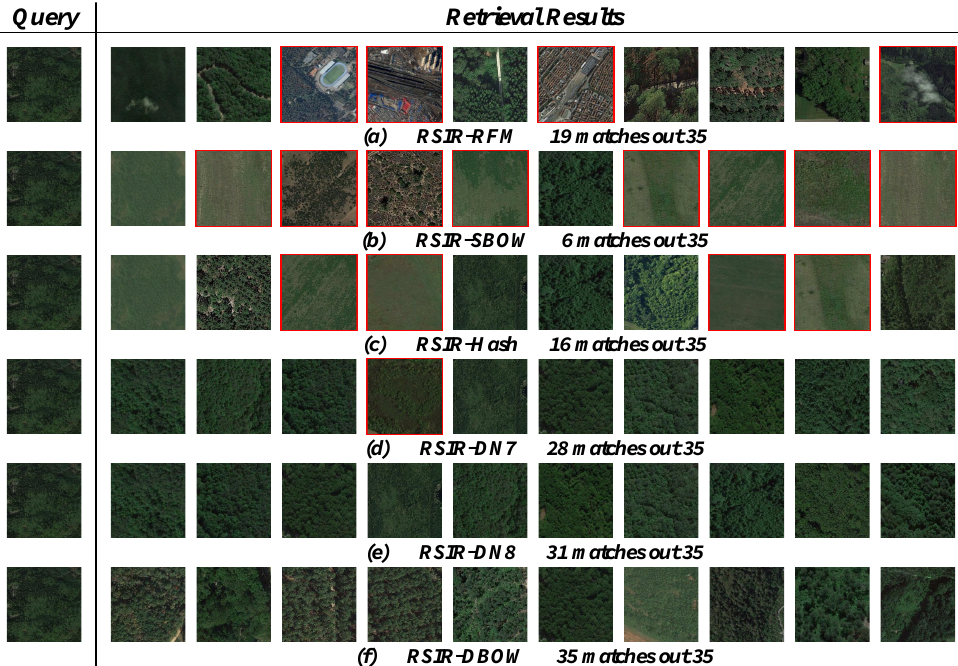
Figure 22. Retrieval examples of “Forest” within ImgDB4 using different RSIR methods. The first images on the left in each row are the queries. The rest of the images in each row are the top 10 retrieval results. The incorrect results are tagged in red, and the number of correct results among the top 35 retrieval images is also